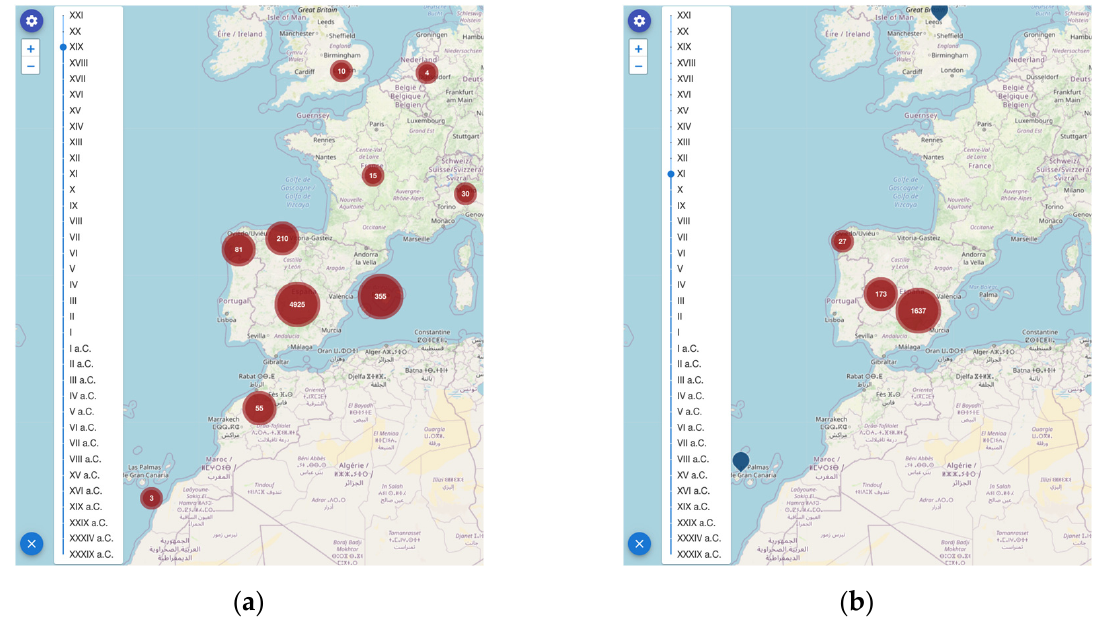
Figure 6. Example of the temporal scale, where: ( a ) 19th century; ( b ) 11th century.